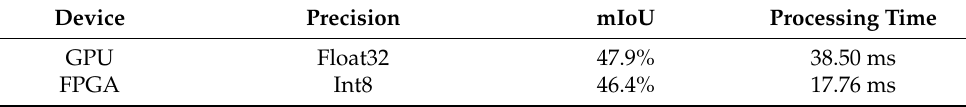
Table 4. Run-time Performance of the Proposed Approach on Semantic-KITT Dataset.